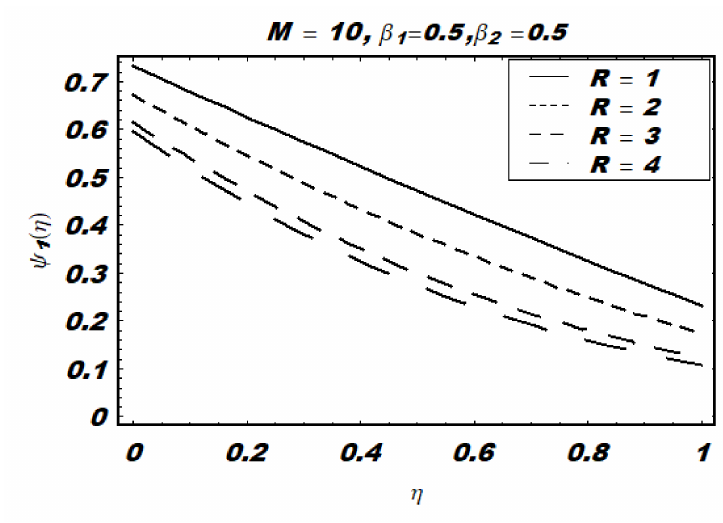
Figure 15. Similarity function ψ 1 for the long